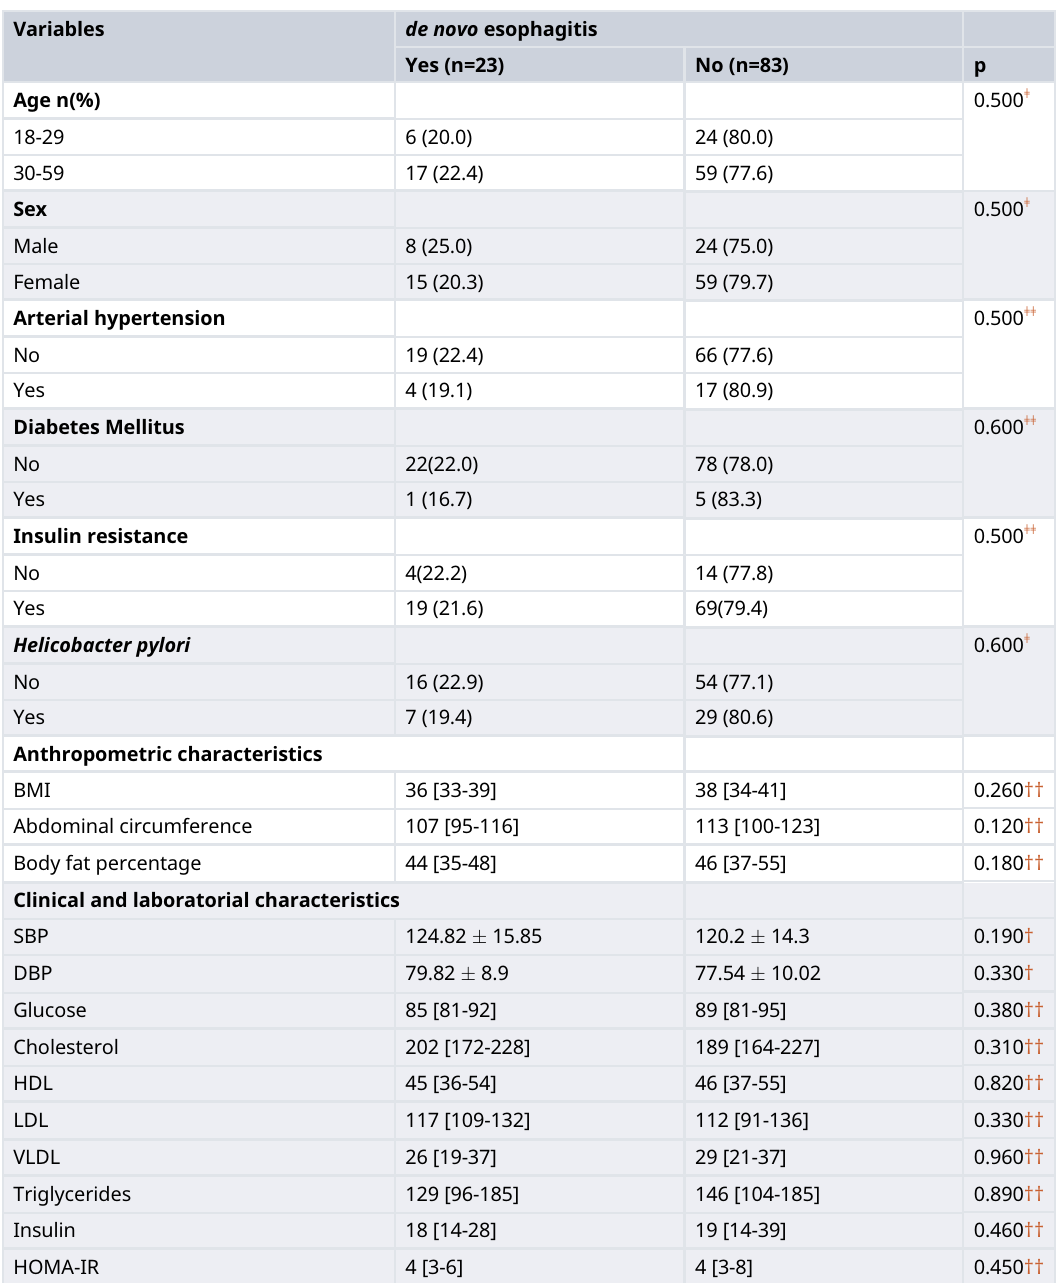
Table 3. De novo esophagitis according to sociodemographic,clinic and laboratory characteristics, comorbidities, presence of Helicobacter pylori and anthropometric characteristics